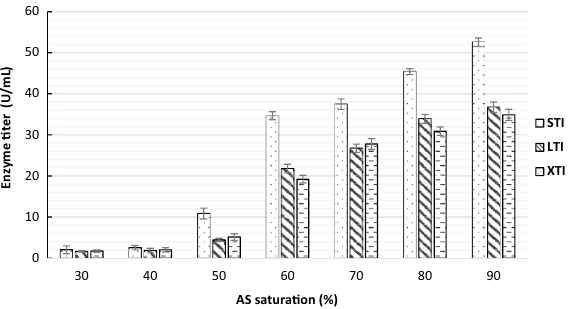
Figure 5. Comparison of laminarinase activity in ammonium sulfate (AS) precipitated and dialyzed samples of Streptomyces rimosus AFM-1. Short time incubation (STI) (20 min), long time incubation (LTI) (3 h) and extended time incubation (XTI) (8 h) using DNS assay.